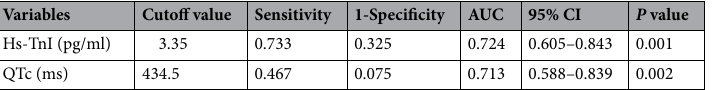
Table 7. ROC curve analysis of hs-TnI and QTc for the diagnosis of cardiotoxicity. The cutoff values are the parameter value corresponding to the maximum value obtained by subtracting sensitivity − (1-specificity), at this threshold, the value of the Yoden index is the highest, that means, the highest accuracy of disease diagnosis. CI confidence interval, ROC receiver–operator characteristic.